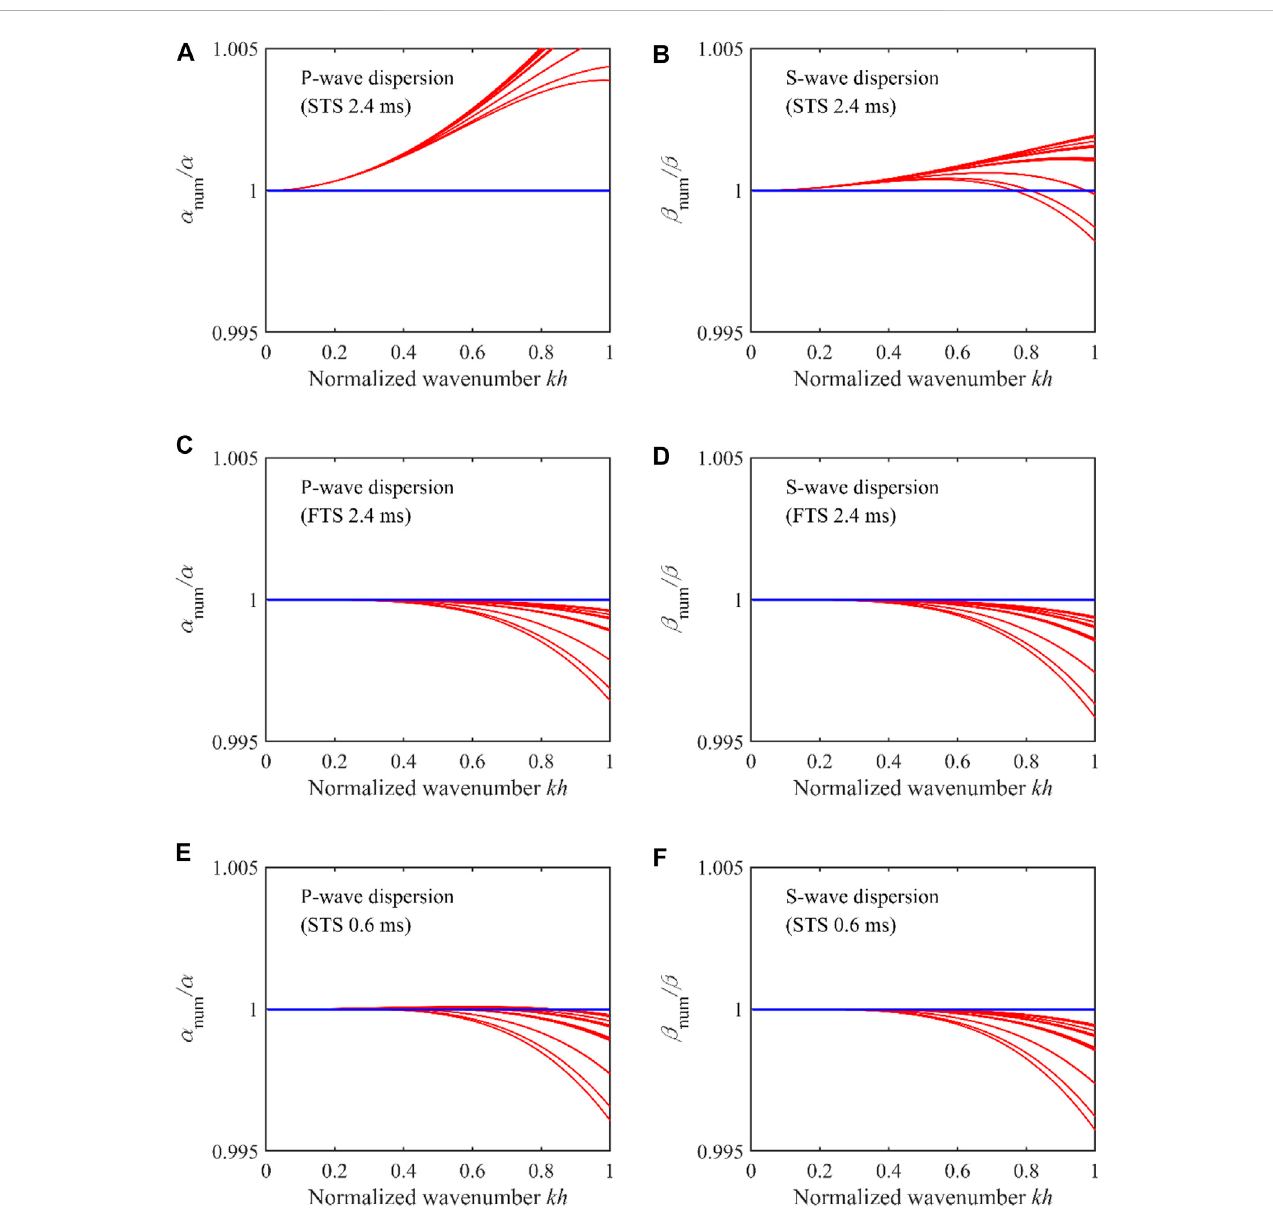
FIGURE 5 Dispersioncurvesfor (A) and (B) theSTSwithatimestepof2.4ms, (C) and (D) theFTSwithatimestepof2.4ms,and (E) and (F) theSTSwithatimestepof 0.6 ms. (A) , (C) and (E) are for P waves, and (B) , (D) and (F) are for S waves. The fourth-order spatial SGFD accuracy is used. In each panel, they are twenty- fi ve curves from bottom to top corresponding to the increases of two propagation angles of θ 1 (cid:1) 0 , π /16 , ... , π /4 and θ 2 (cid:1) 0 , π /16 , ... , π /4,